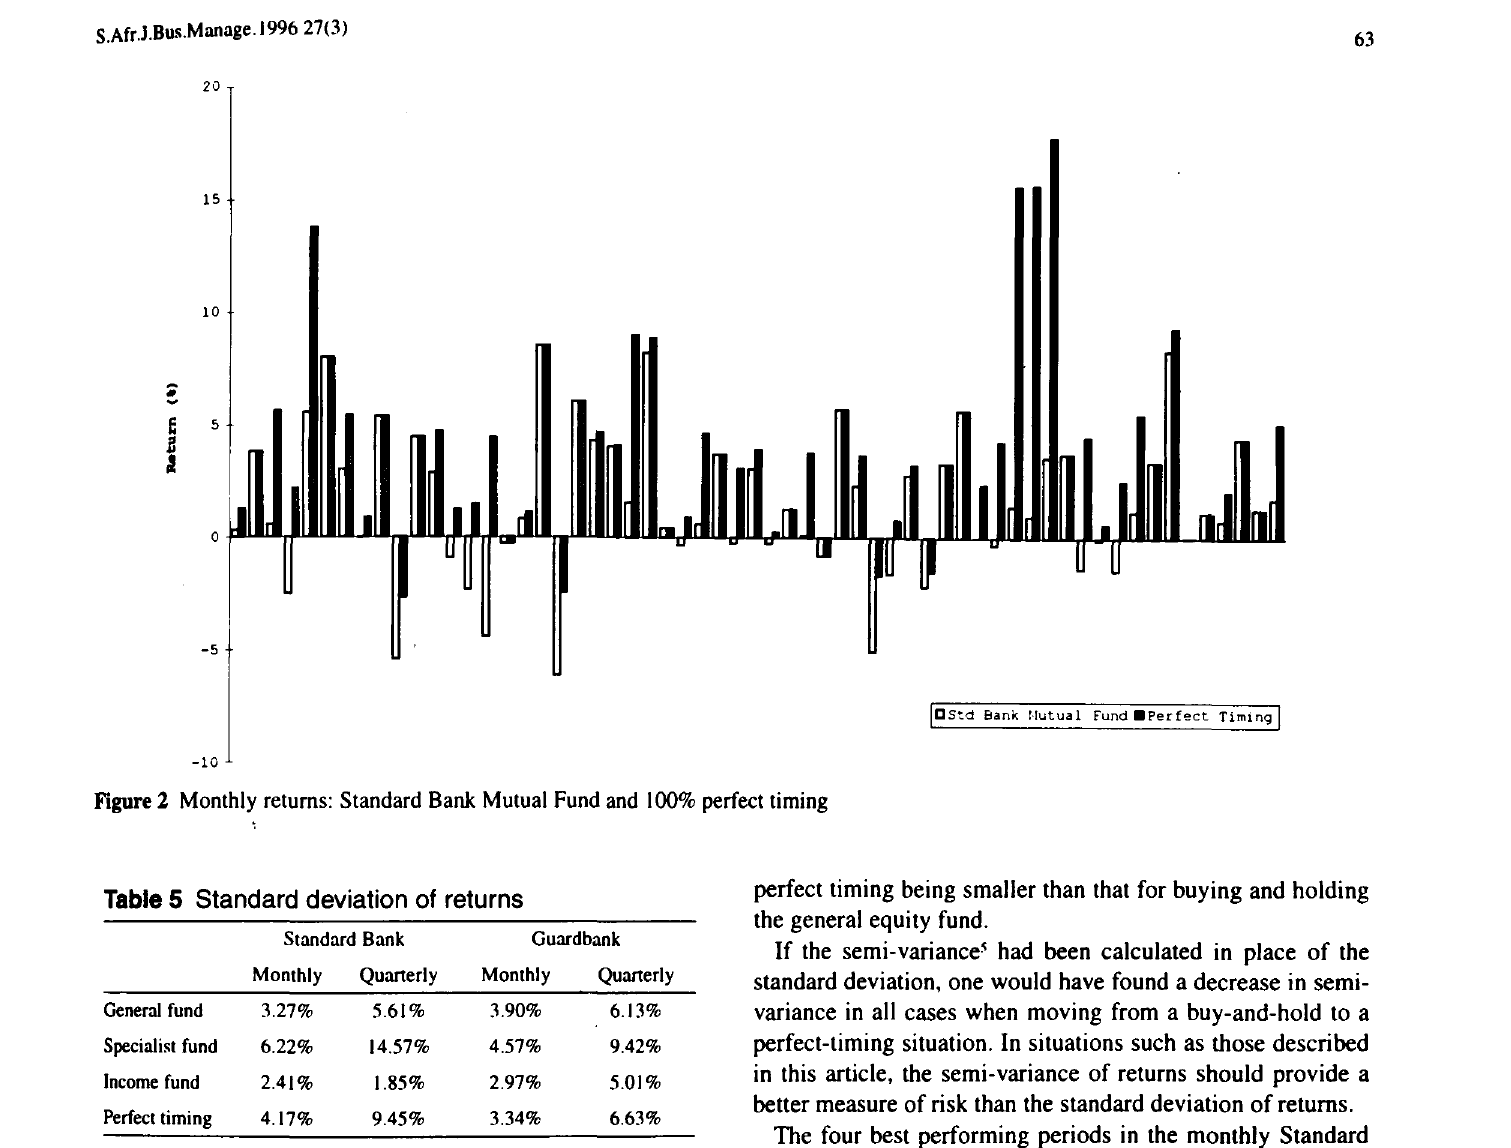
Figure 2 Monthly returns: Standard Bank Mutual Fund and 100% perfect timing